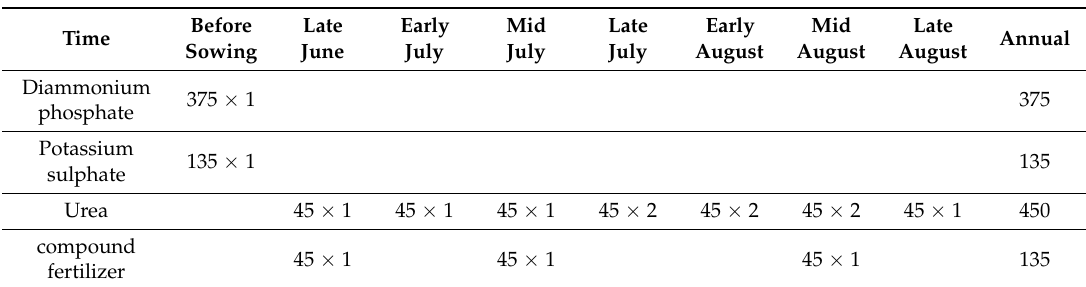
Figure 3. Layout of drip lines. Table 5. Detail top-dressing scheme.